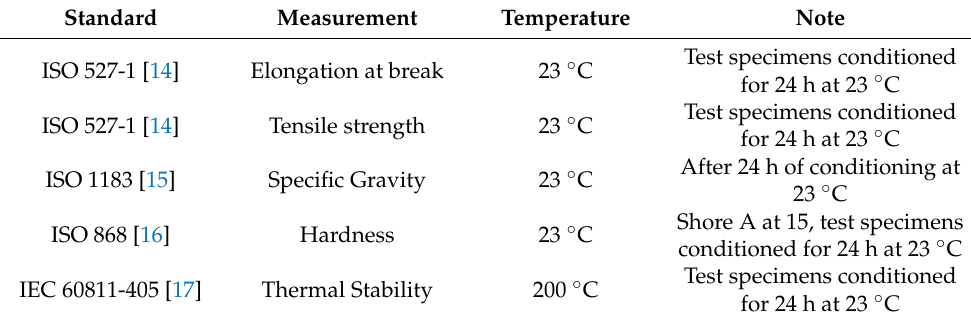
Table 5. Tests for the main properties of the compound.